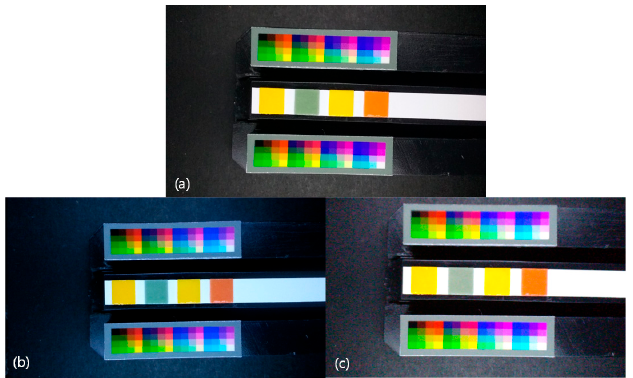
Figure 3. Captured images of pH 7.0 strip from three different smartphones. ( a – c ) corresponds to images from smartphone A~C, respectively.